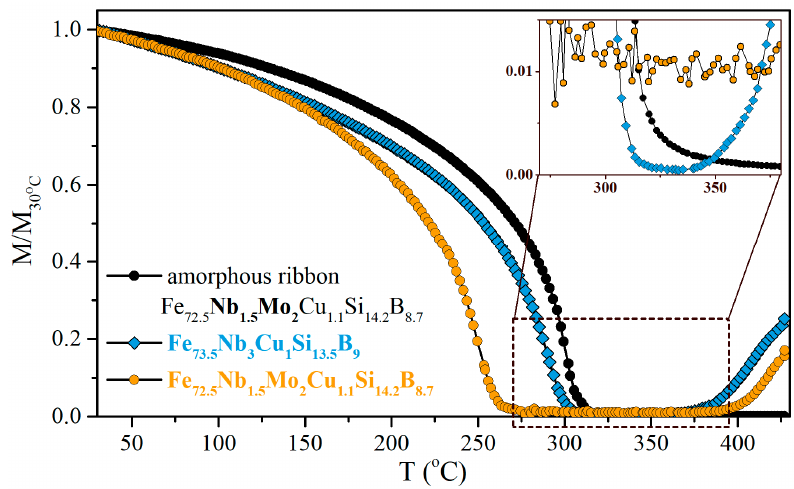
Figure 1. M vs. T dependences of Fe 72.5 Nb 1.5 Mo 2 Cu 1.1 Si 14.2 B 8.7 and Fe 73.5 Nb 3 Cu 1 Si 13.5 B 9 films with the thickness of 200 nm and amorphous ribbon Fe 72.5 Nb 1.5 Mo 2 Cu 1.1 Si 14.2 B 8.7 for the Curie temperature evaluation. The inset shows the transition region with better resolution.